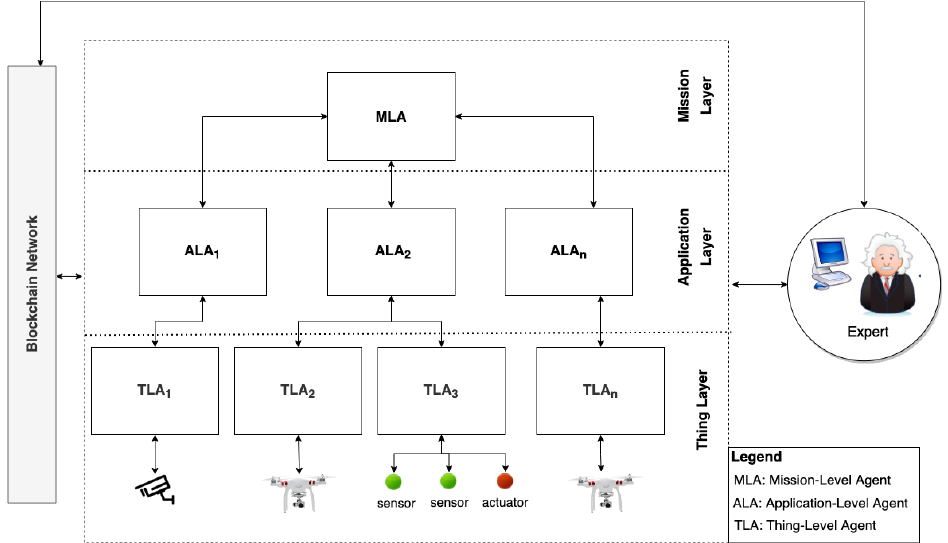
Figure 2. The abstract architecture of our